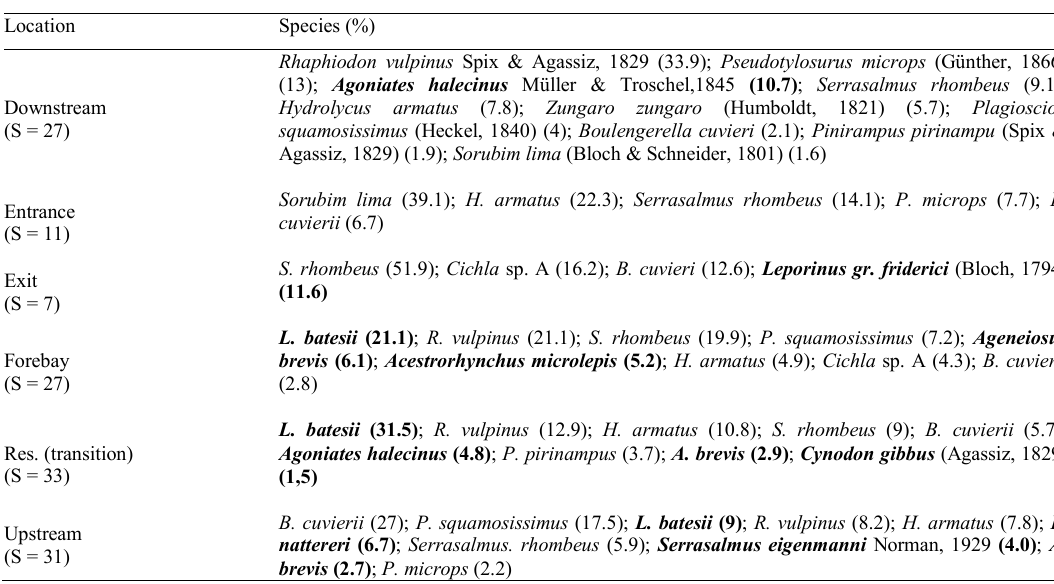
Table 1. Piscivorous species that account for 90% of the total fish from this trophic group caught along the Lajeado Dam fish ladder (entrance and exit), and in the areas adjacent to the dam (downstream, forebay, transition stretch of the reservoir, and upstream). The total number of piscivorous fish species in the different locations is also shown (S). The bold typeface denotes species with a maximum standard length of less than 40